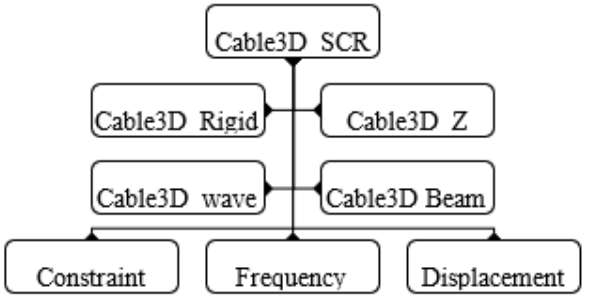
Figure 1. Process of the structural model.